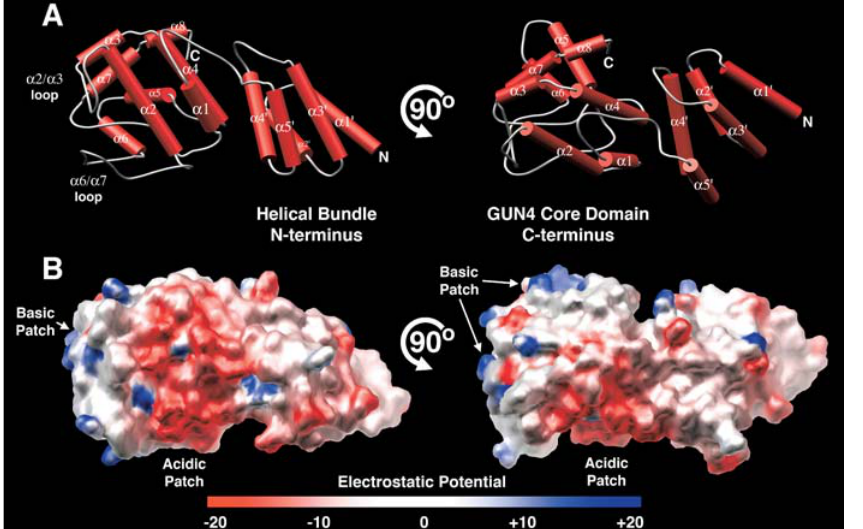
Figure 1. Overall Structure of Synechocystis GUN4 (A) Orthogonal views of the crystal structure of the full length (residues 1–233) Synechocystis GUN4 protein (SynGUN4). Helices are shown as red cylinders and loop regions are displayed as gray loops. SynGUN4 contains two distinct domains linked by a flexible loop. The helices of the N- terminal domain are labeled with apostrophes to distinguish them from the helices making up the C-terminal domain. All structure figures were made with MOLSCRIPT [57] and POV-Ray (http://www.povray.org). (B) Orthogonal views of the GRASP [58] representation of the SynGUN4 solvent-accessible surface colored to approximately reflect the underlying electrostatic potential, where blue is positive, red is negative, and white is neutral. DOI: